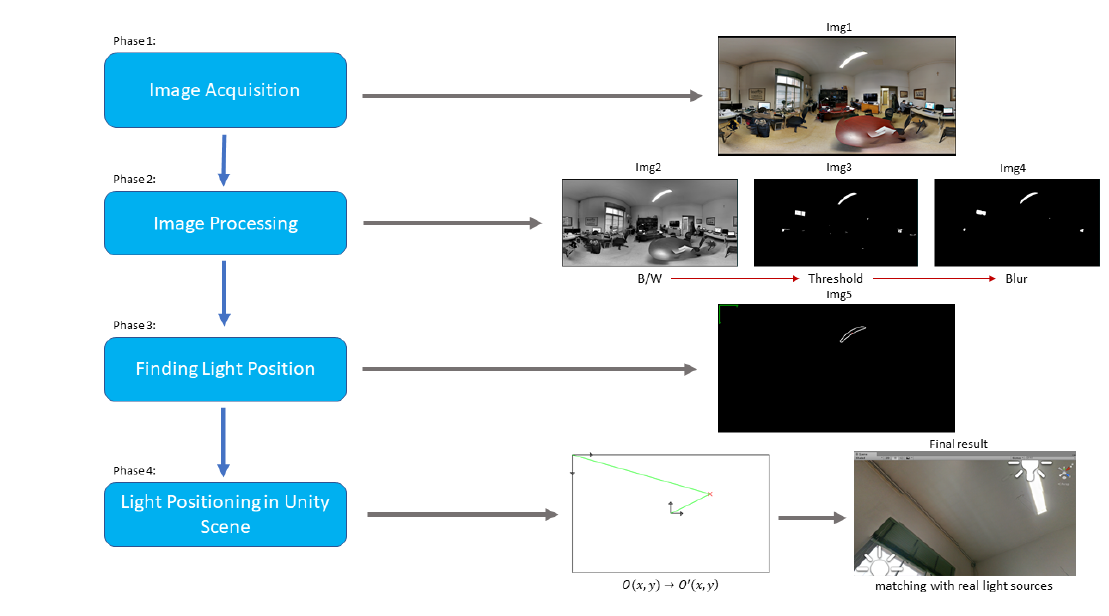
Figure 2. Logical map